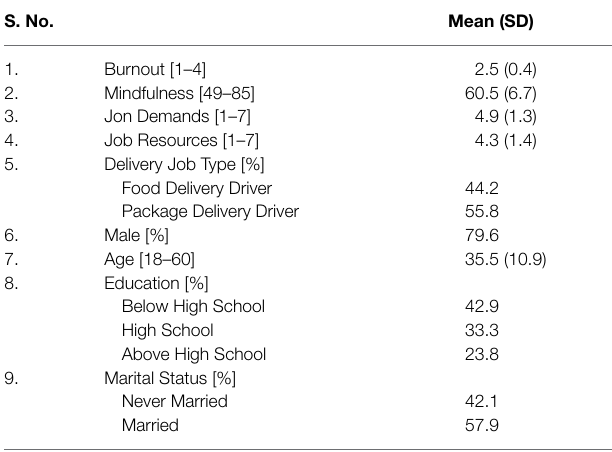
TABLE 1 | Descriptive statistics of key